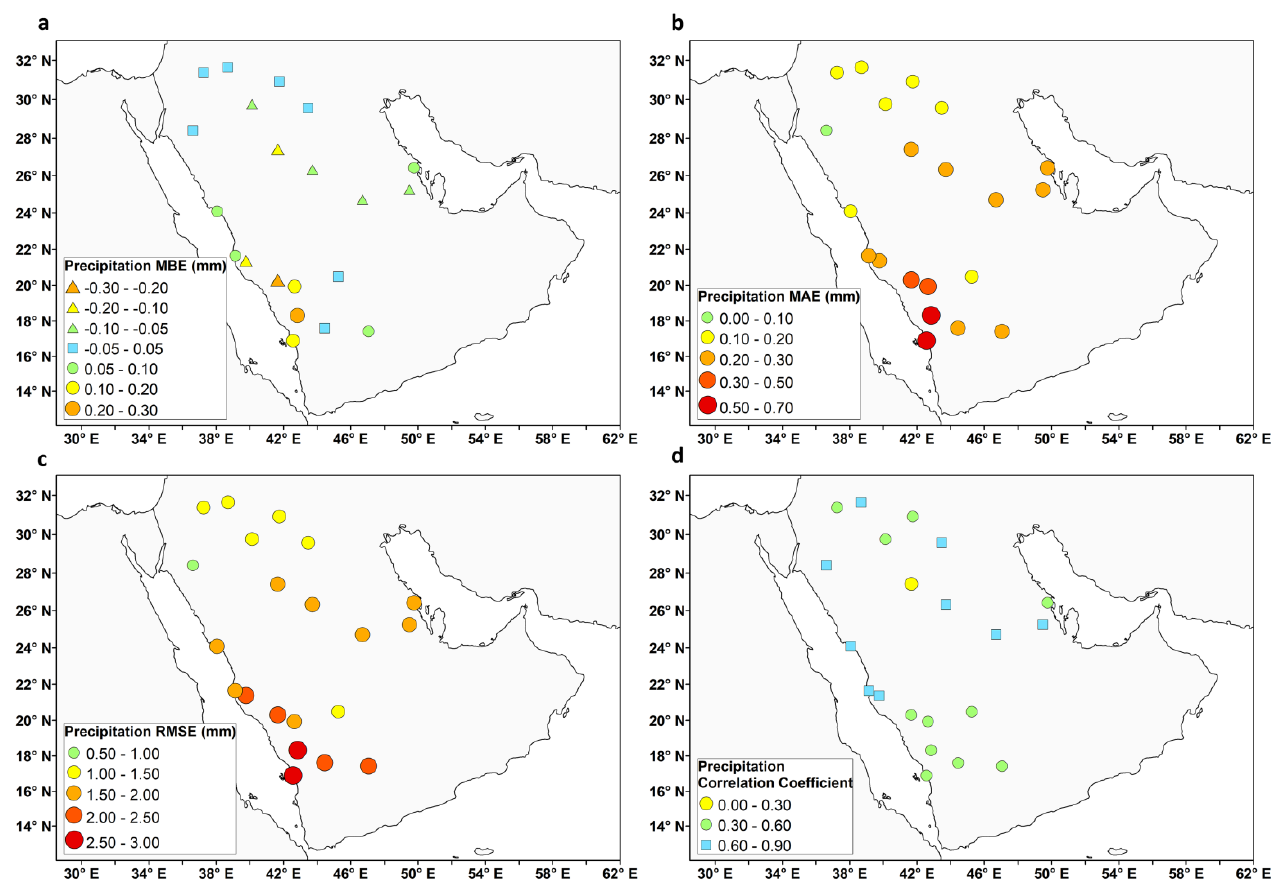
Figure 4. ( a ) MBE, ( b ) MAE, ( c ) RMSE and ( d ) Correlation Coefficient between modeled and station precipitation data.